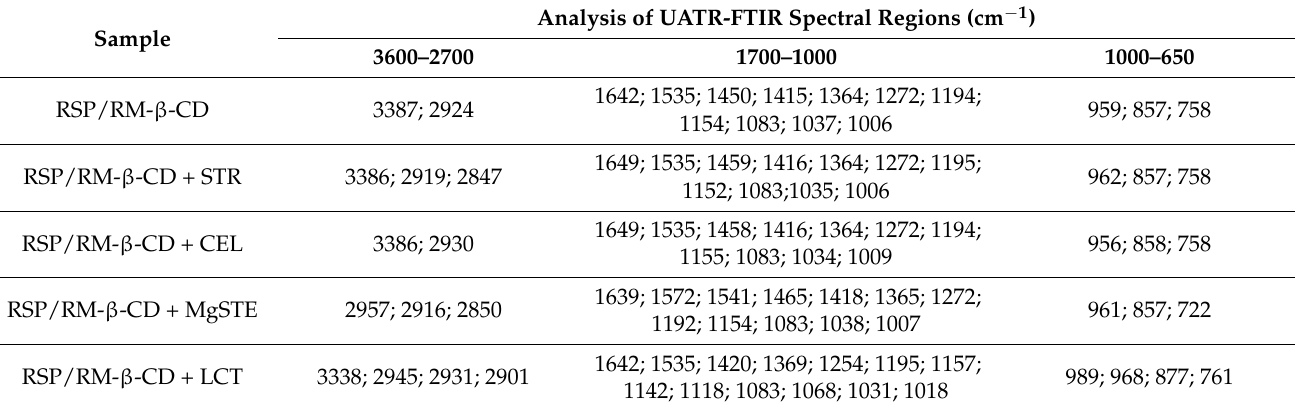
Table 1. UATR-FTIR characteristic bands for RSP/RM- β -CD and its mixtures with excipients.